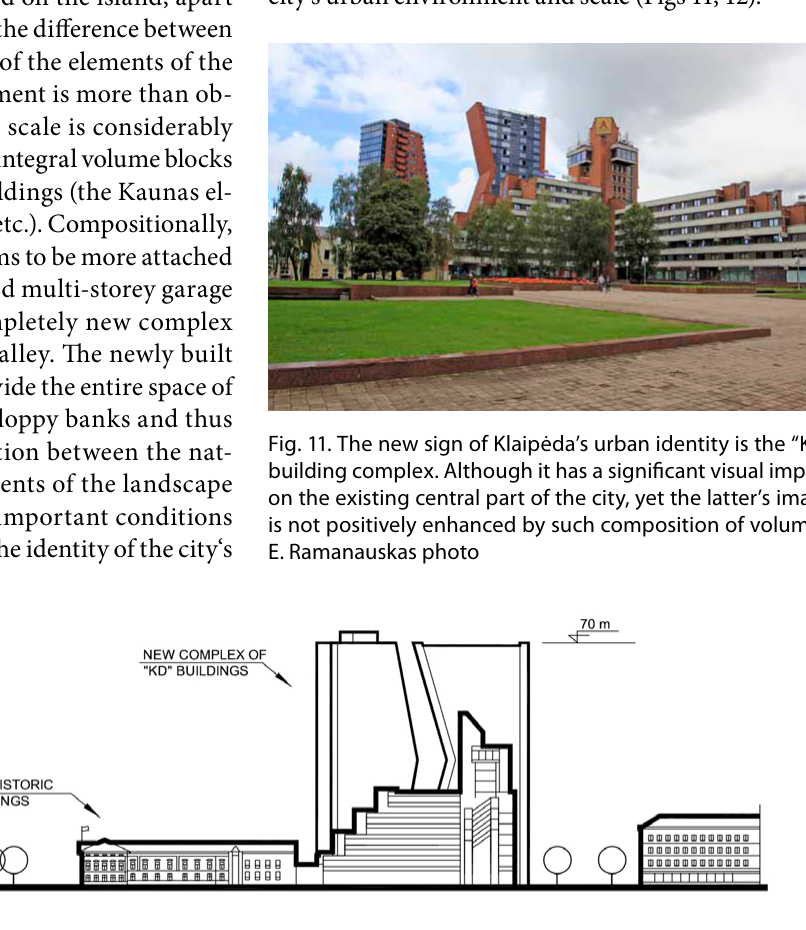
fig. 12. The complex of the KD buildings in Klaipėda was built near the old houses and thus overshadowed them by creating a relatively hypertrophied scale background